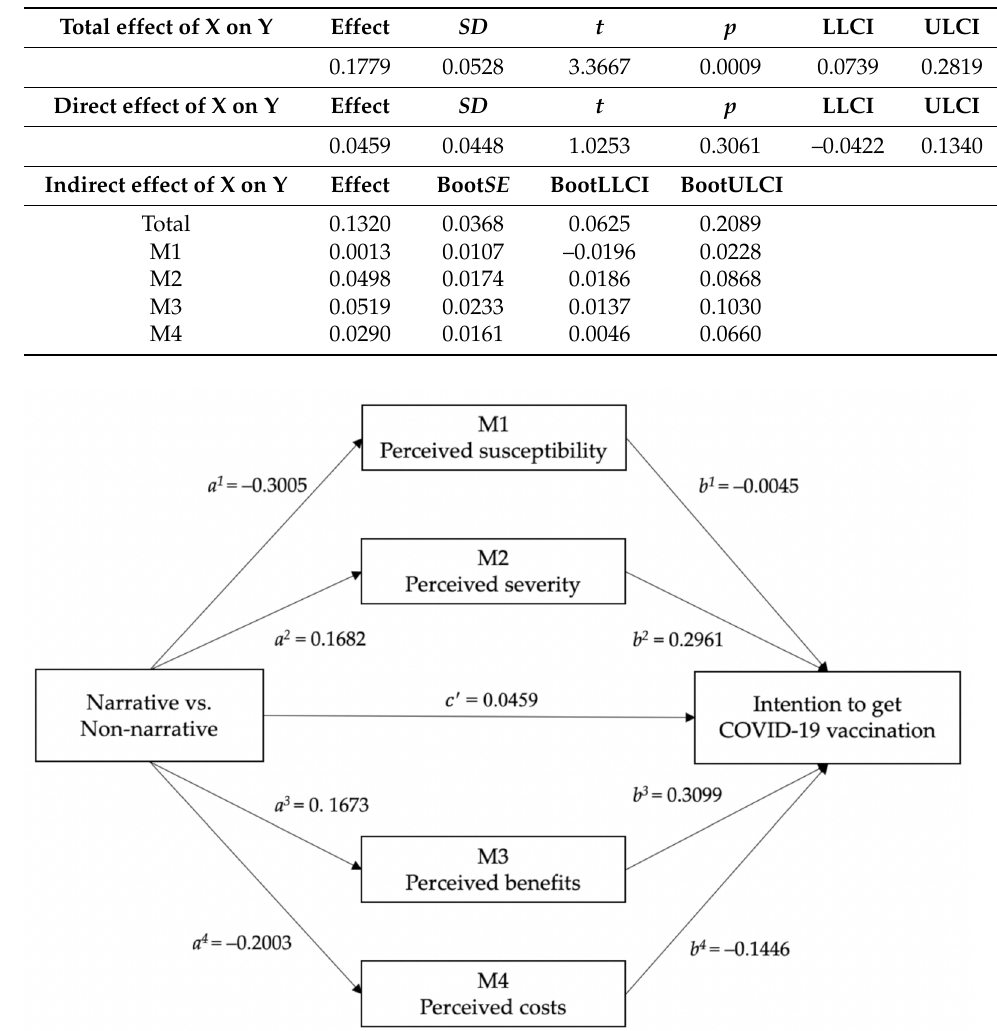
Table 3. Mediation effects related to research questions 4–5.